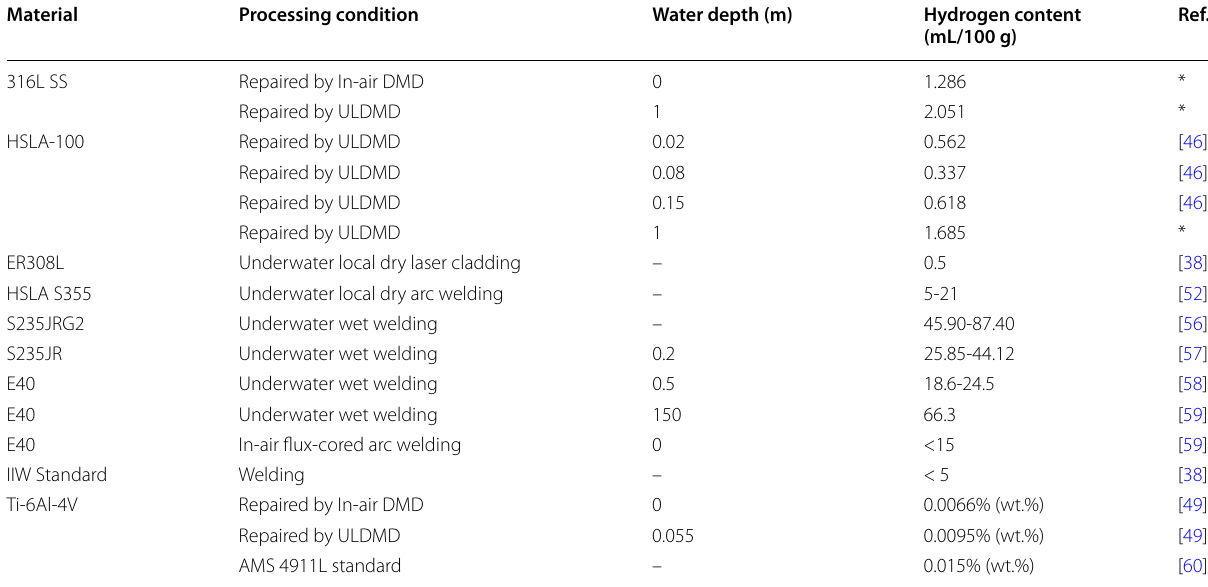
Note: The symbol * represents that the data were obtained by the authors